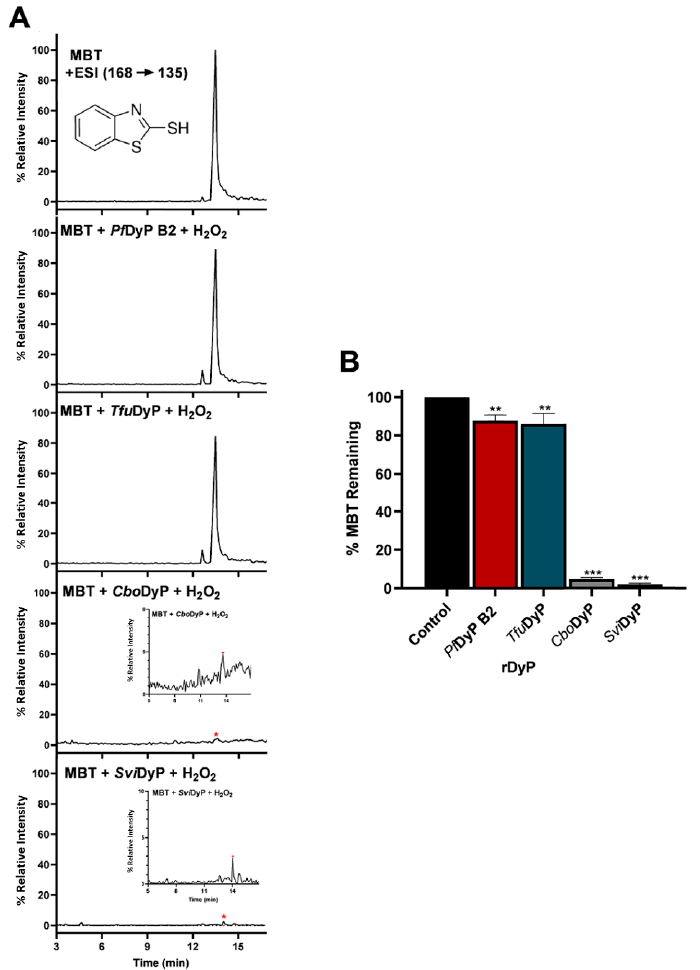
Figure 4. ( A ) MRM chromatograms of MBT untreated and treated samples with Pf DyP B2, Tfu DyP, Cbo DyP and Svi DyP. ( B ) Percentage of MBT remaining upon degradation by Pf DyP B2, Tfu DyP, Cbo DyP and Svi DyP. Reaction conditions: [EP] = 4 ppm, [ Pf DyP B2] = 0.255 µ M, [ Tfu DyP] = 0.087 µ M, [ Cbo DyP] = 4.33 µ M, [ Svi DyP] = 2.8 µ M, [H 2 O 2 ] = 0.25 mM, pH values for Pf DyP B2, Tfu DyP, Svi DyP, and Cbo DyP are 3, 4, 4, and 5, respectively. Insets in the Cbo DyP and Svi DyP panels show zoomed in chromatograms with the red asterisk showing the residual MBT. ** p < 0.01 *** p < 0.001 compared to the